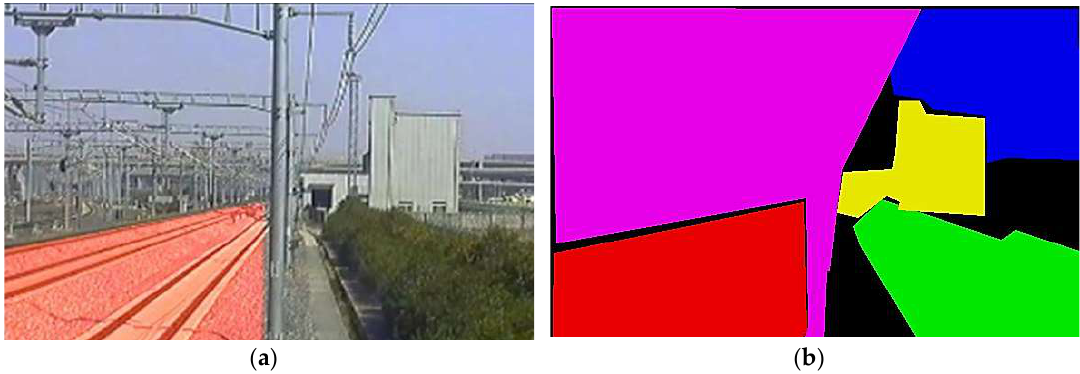
Figure 2. Railway scene and the local areas, labeled manually. The image quality is susceptible to external influences, such as the illumination, weather, and even the dust on the lens. ( a ) The red area is the track area to be surveilled. The track area includes the rails, sleepers, subgrades, or high-speed railway slabs. ( b ) Labeling the different area of the railway scene with different colors by manual, including track area ( red ), sky ( blue ), catenary system ( purple ), green belt ( green ), and ancillary buildings ( yellow ). The precision depends on the patience of the manual operator.